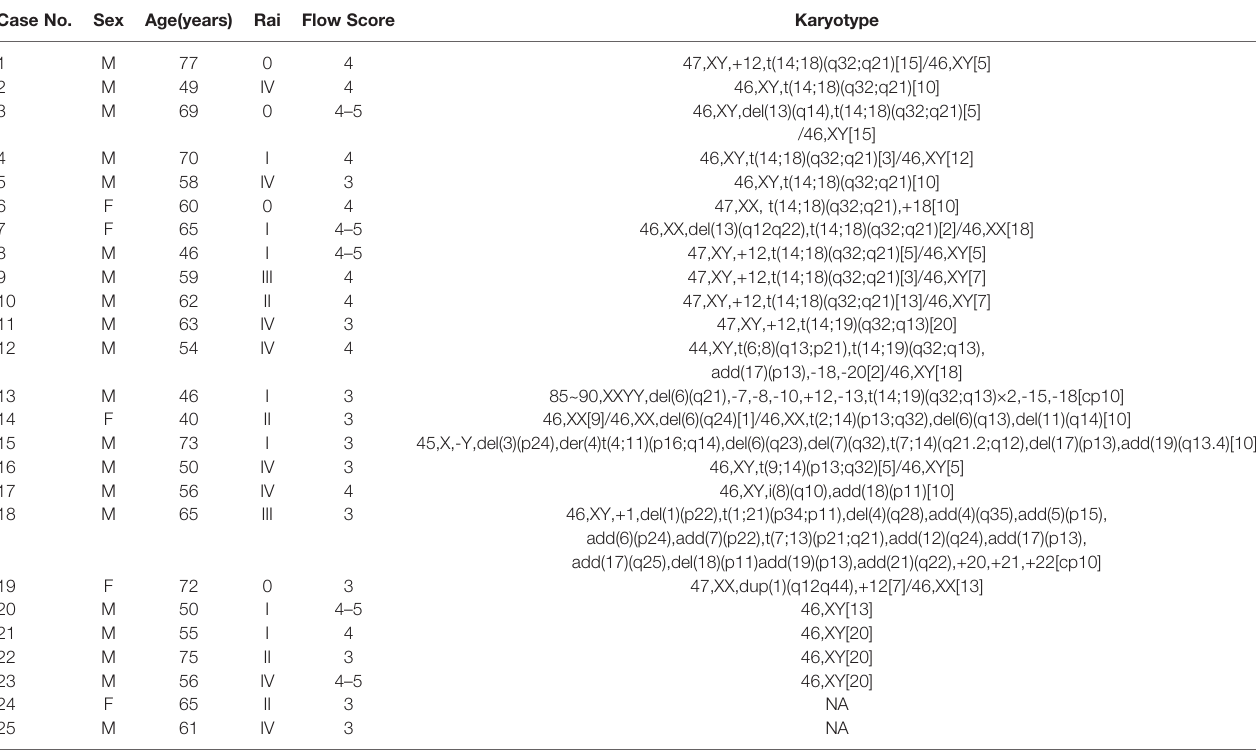
TABLE 3 | Clinicopathologic features and cytogenetic karyotype results of 25 patients with IGH gene rearrangement. Case No. Sex Age(years) Rai Flow Score